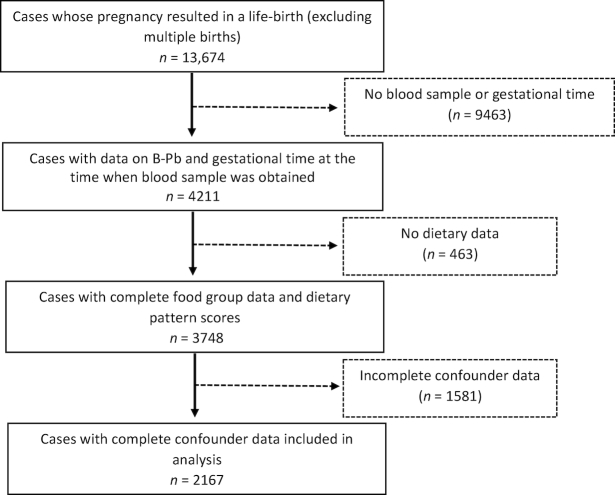
Study flow chart.